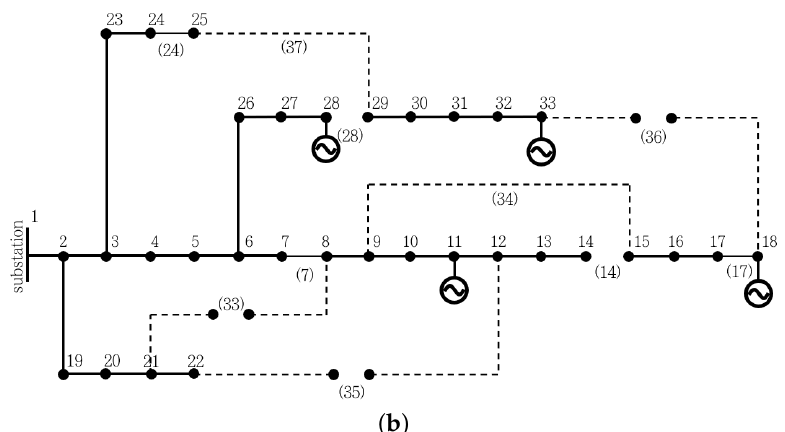
Figure 8. Distribution system topology of the test day. ( a ) Topology index for three algorithms (DC and SW-DRL, Myopic, and HMA-DRL); ( b ) topology